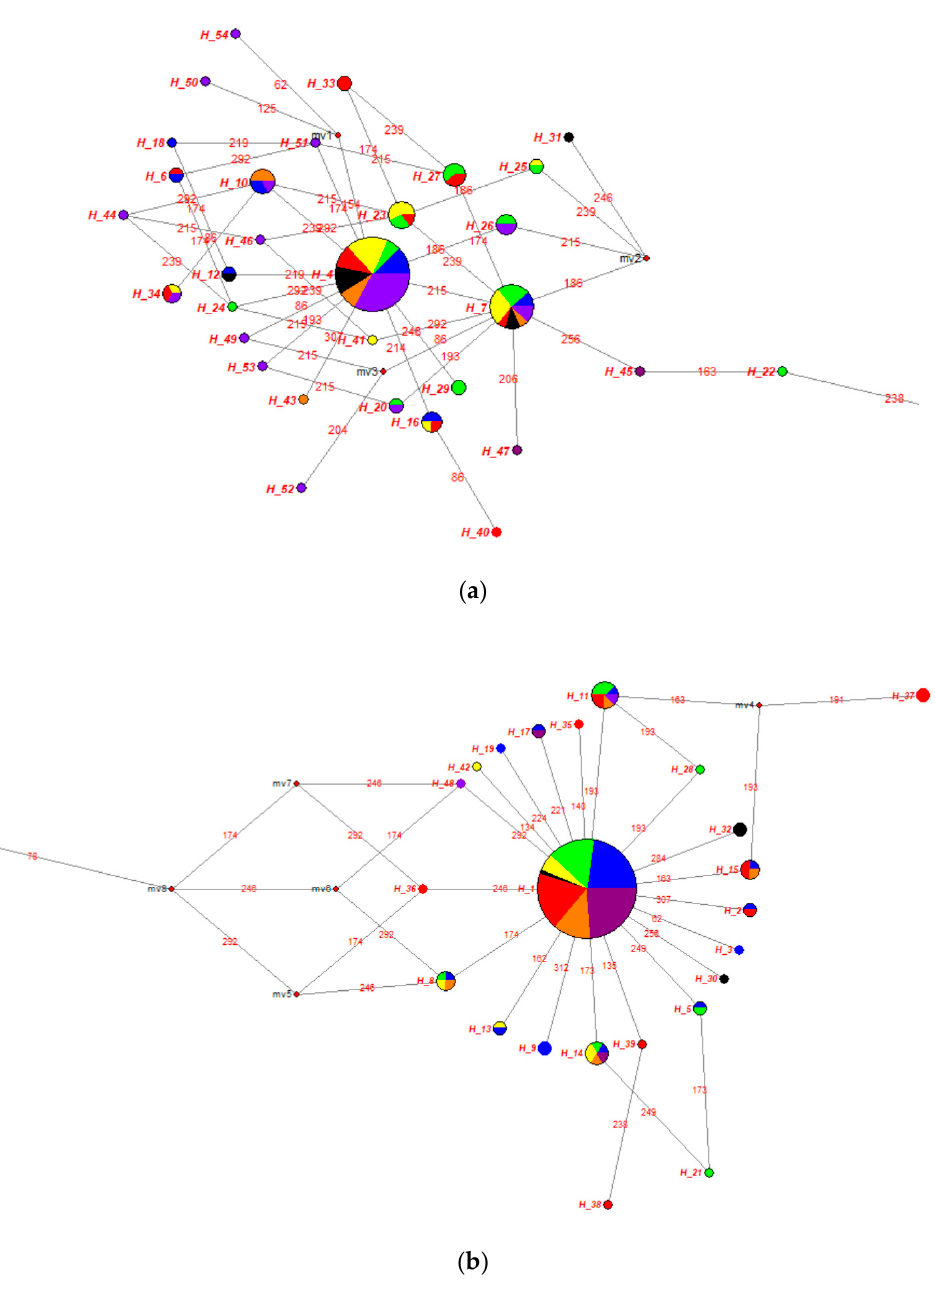
Figure 6. Clade I ( a ) and Clade II ( b ) median-joining network constructed from 54 haplotypes obtained from seven different geographical regions and 16 different populations (MRM: Blue, BSR: Green, AER: Yellow, MDR: Red, CAR: Black, EAR: Orange, SAR: Purple).